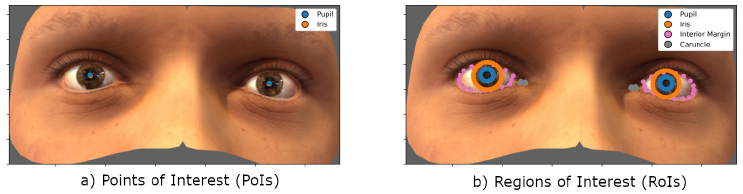
Figure 2. Example showing the correspondence of the features used to establish the methodological framework over an image from the U2Eyes. ( a ) Projection of 3D center of pupil and iris. Points of Interest (PoIs) of the image. ( b ) Segmentation of the pupil, iris, interior margin and caruncle for both eyes. Regions of Interest (RoIs) of the image. Images from U2Eyes database